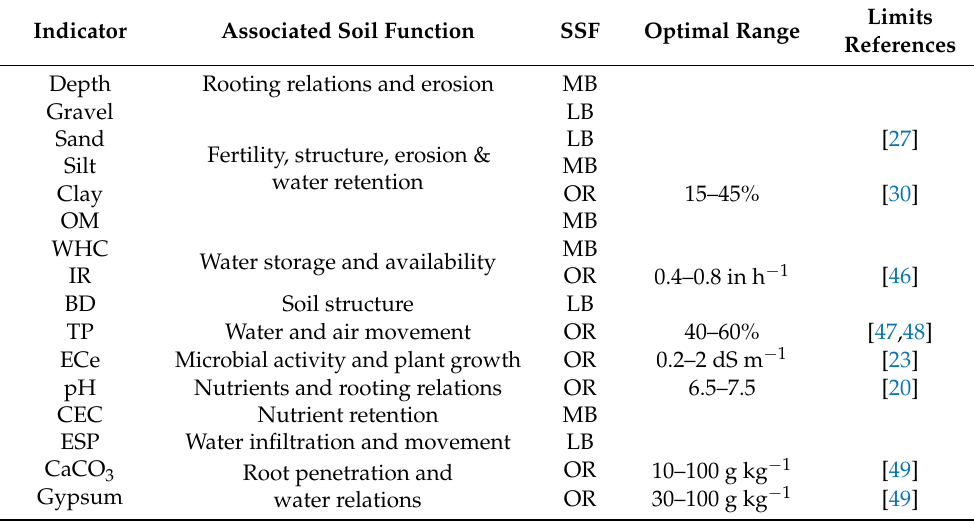
Table 1. Standard scoring function (SSF) of physicochemical indicators to assess soil